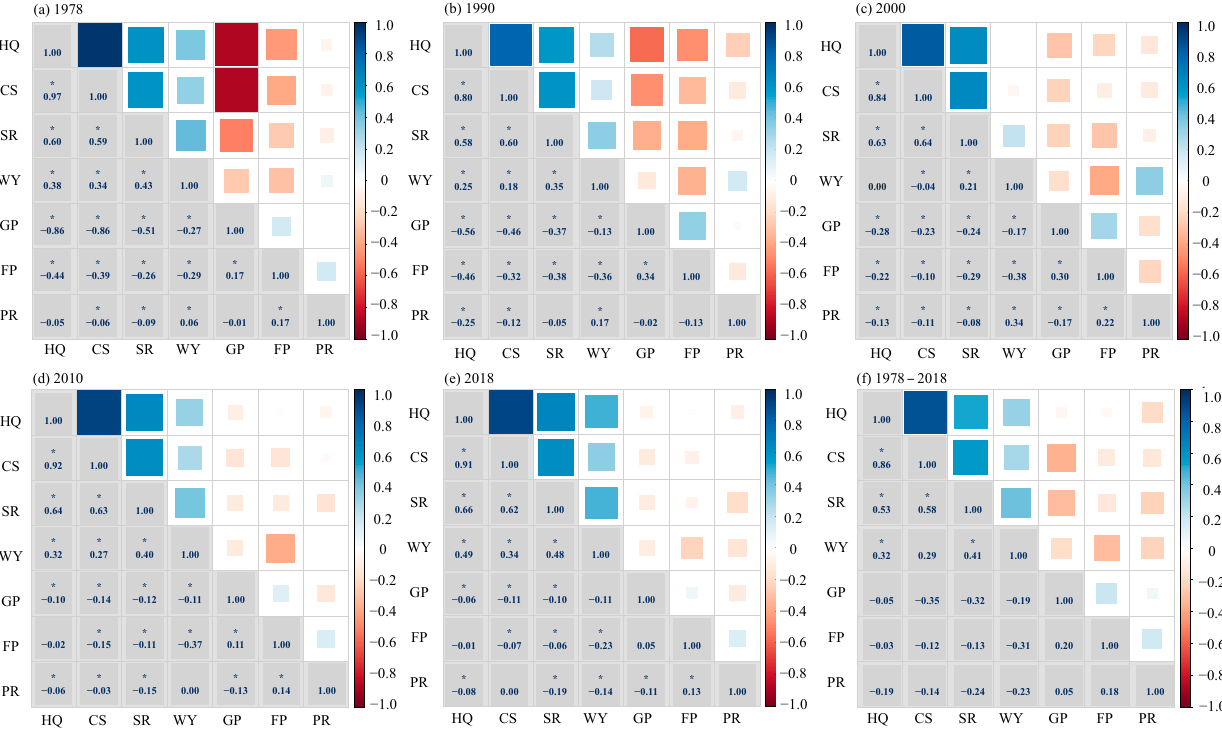
Figure 4. The correlation matrix among ES categories. ( a – e ) correspond to 1978, 1990, 2000, 2010 and 2018 respectively; ( f ) is the difference between 1978 and 2018. Significance level: * indicates p < 0.05.